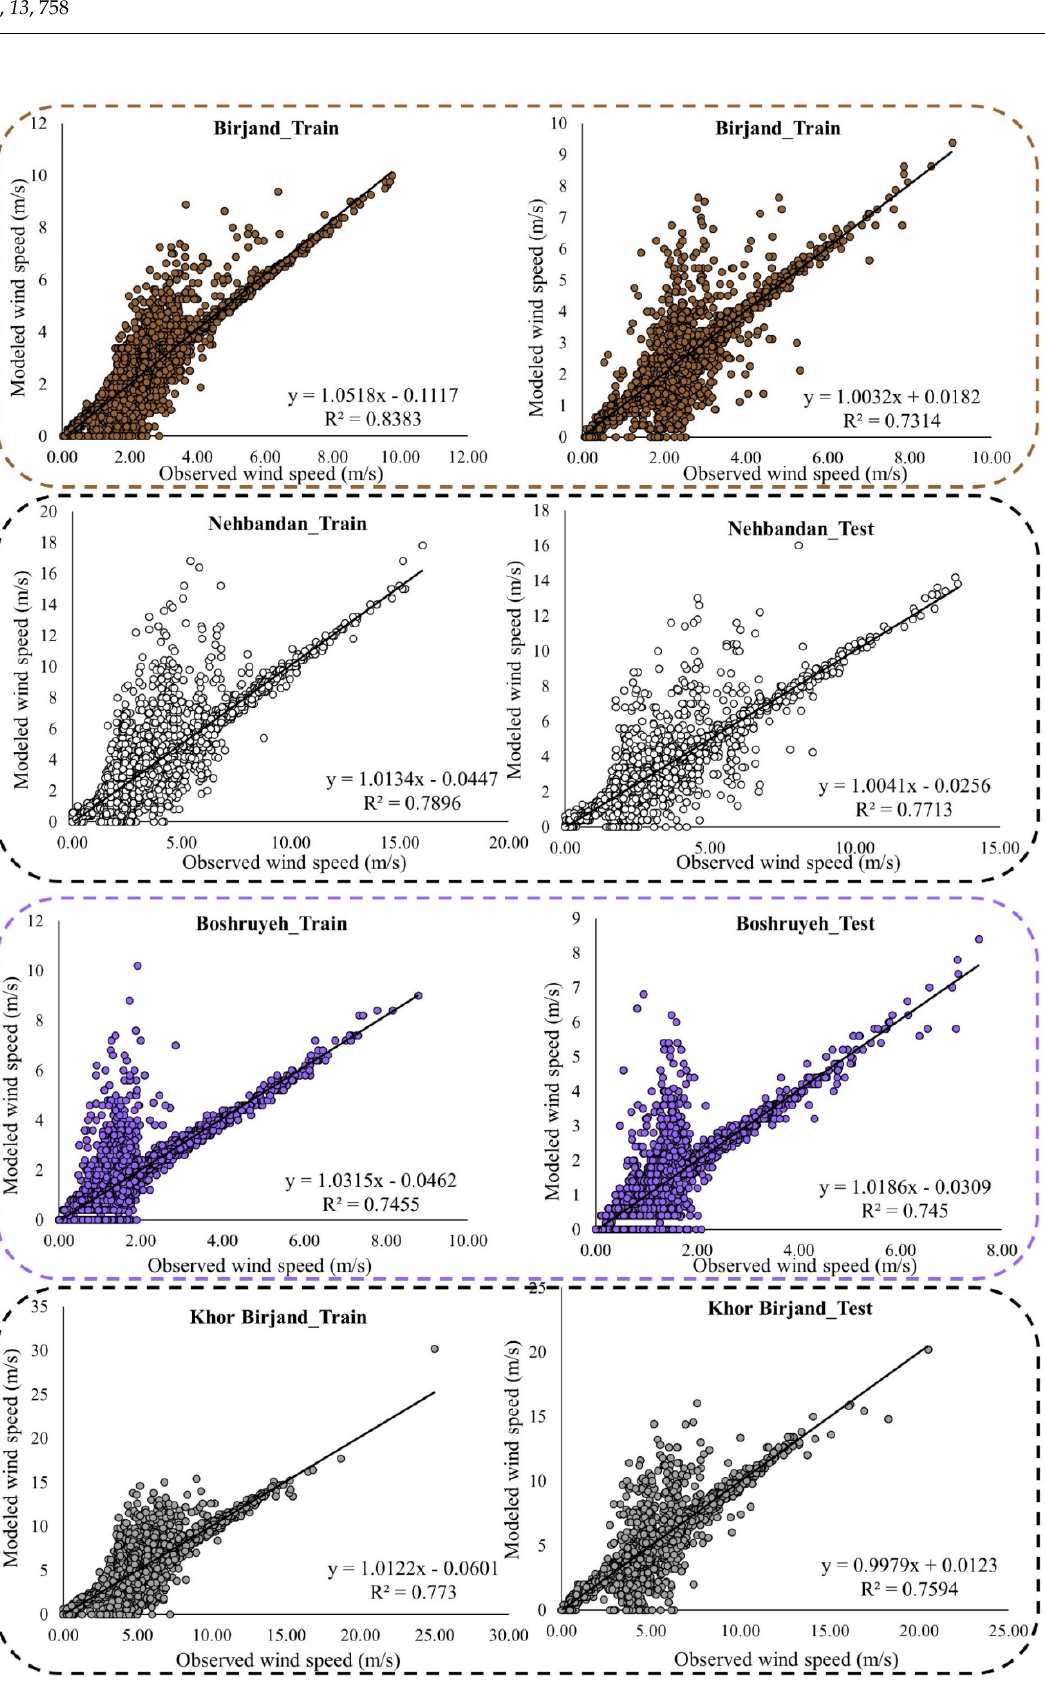
Figure A2. Scattered plots of observed and modeled values of WS by meta-algorithm at different stations.